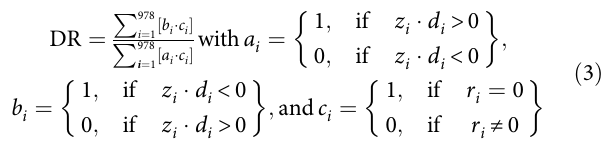
changes (Table 1, Supplementary Figure 2, Supplementary Figure 3, Supplementary Data 3, Supplementary Data 4).